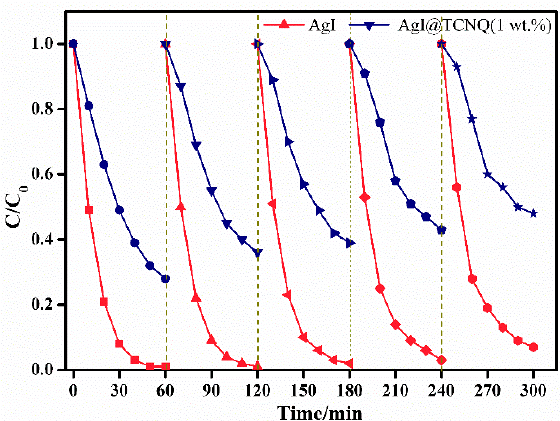
Figure 9. The recycling photodegradation performance of pure AgI and AgI@TCNQ composites.